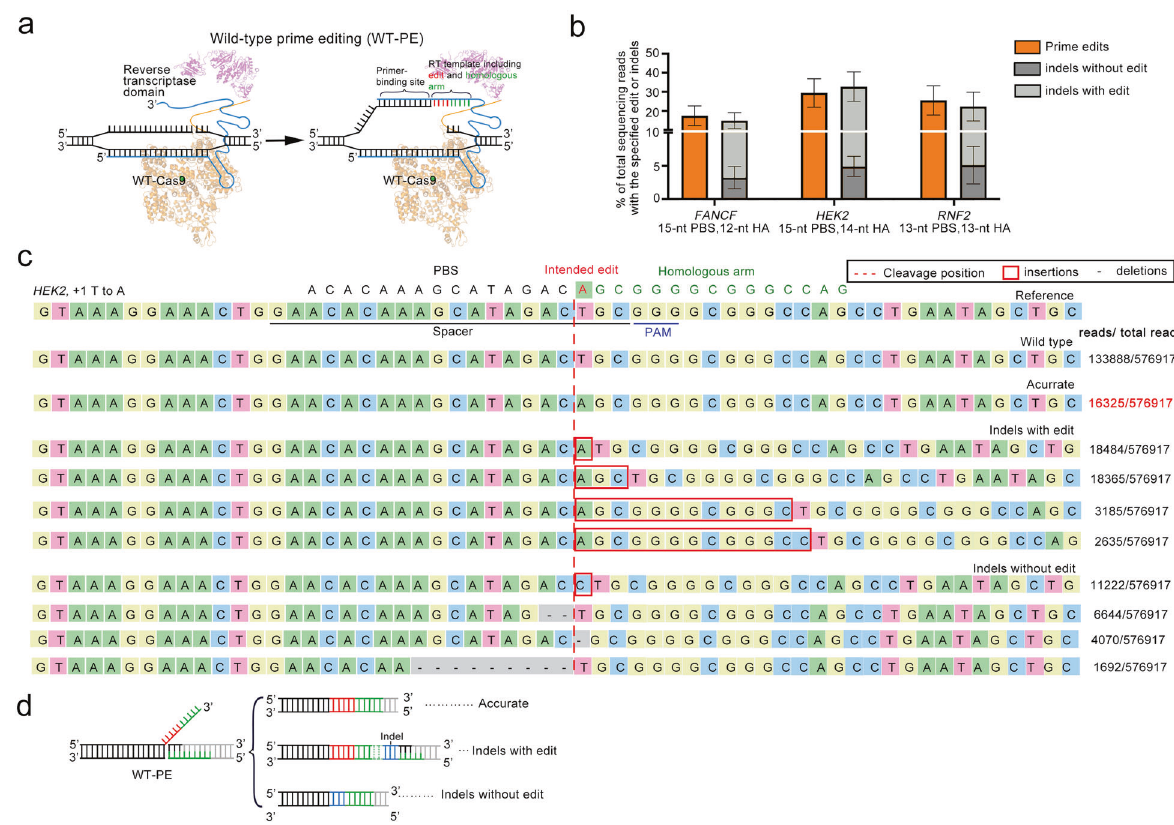
Fig. 1 Design and characterization of WT-PE. a A diagram showing the putative action mode of WT-PE. Different from PE2, WT-PE uses a nuclease preserved spCas9 and introduces DSB in the target site (left panel). The broken non-target strand is then recognized by PBS of the pegRNA and then extended by RT domain in the guidance of RT template. The RT template is designed to contain aimed edit (in red) and a homologous arm (HA, in green) that is complementary to the PAM proximal end of the target strand (right panel). b HTS analysis of the editing outcomes of WT-PE. Three types of outcomes were observed through the HTS: accurate edits, edits containing indels and pure indels. The prime edits represented accurate edits + edits containing indels. Plots showed mean ± s.d. of three independent biological replicates. c Sequence alignment showing top 10 sequences of WT-PE outcomes in HEK2 locus. Desired sequence containing + 1 A to T conversion served as a reference sequence with spacer and PAM sequences underlined. The position of DSB was labeled with a red dash. d Schematic diagram of three types of